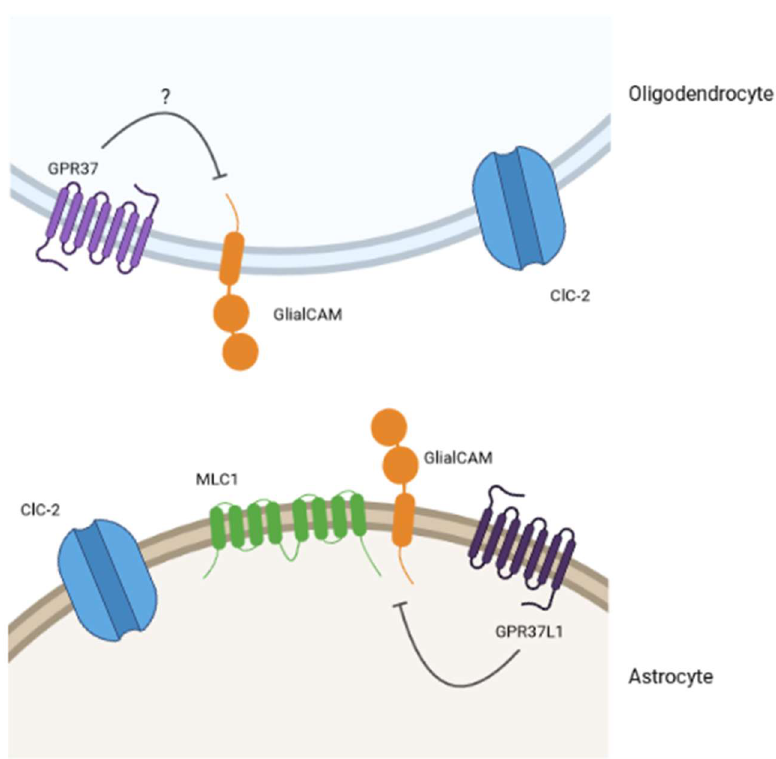
Figure 4. Model for the interplay between GPCRs and MLC-related proteins. The existing pieces of evidence in the literature and the results from our lab lead us to think that GPR37 and GPR37L1 would be part of an interplay with MLC-related proteins. Specifically, we hypothesize (question mark for GPR37 in oligodendrocytes) that these GPCRs would be negative regulators of the physiological MLC1/GlialCAM complex activity.